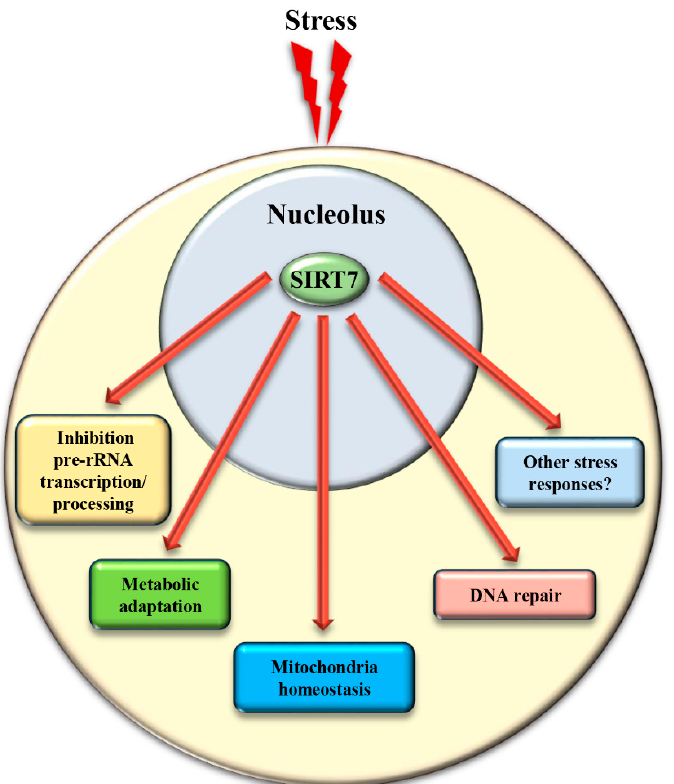
Figure 4. Translocation of SIRT7 from the nucleolus following stress is a critical event to activate SIRT7 -regulated extra-nucleolar functions. See text for details.